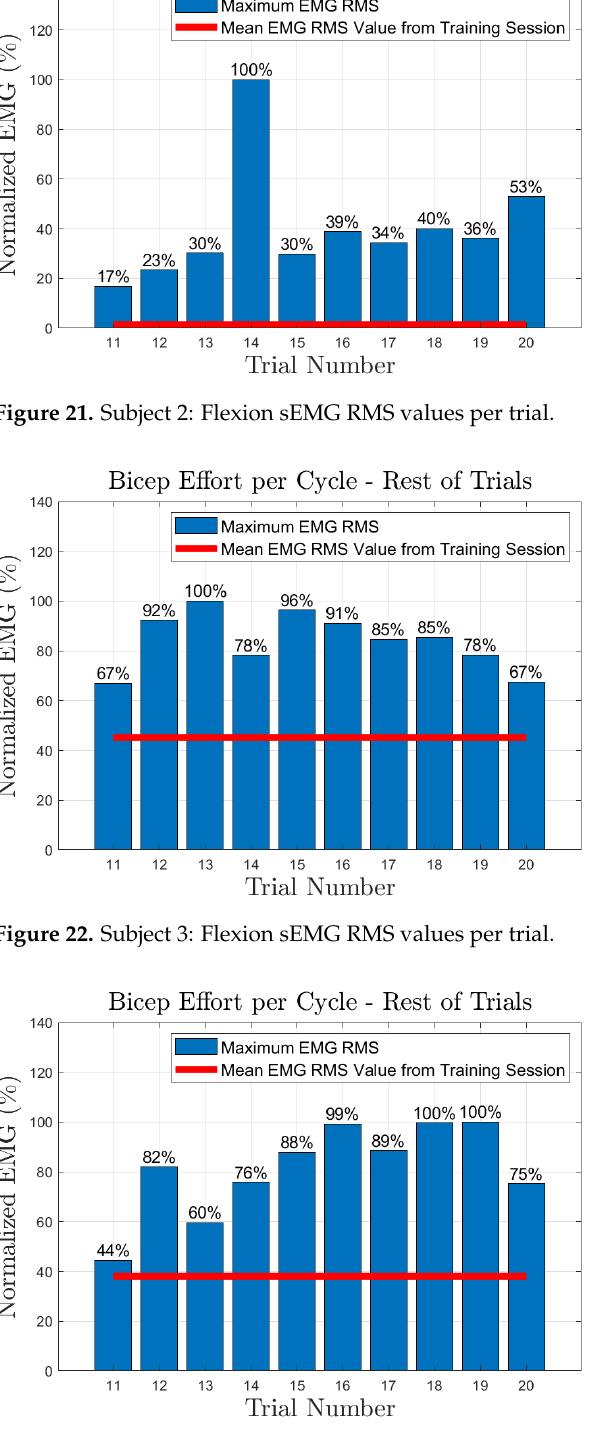
Figure 23. Subject 4: Flexion sEMG RMS values per